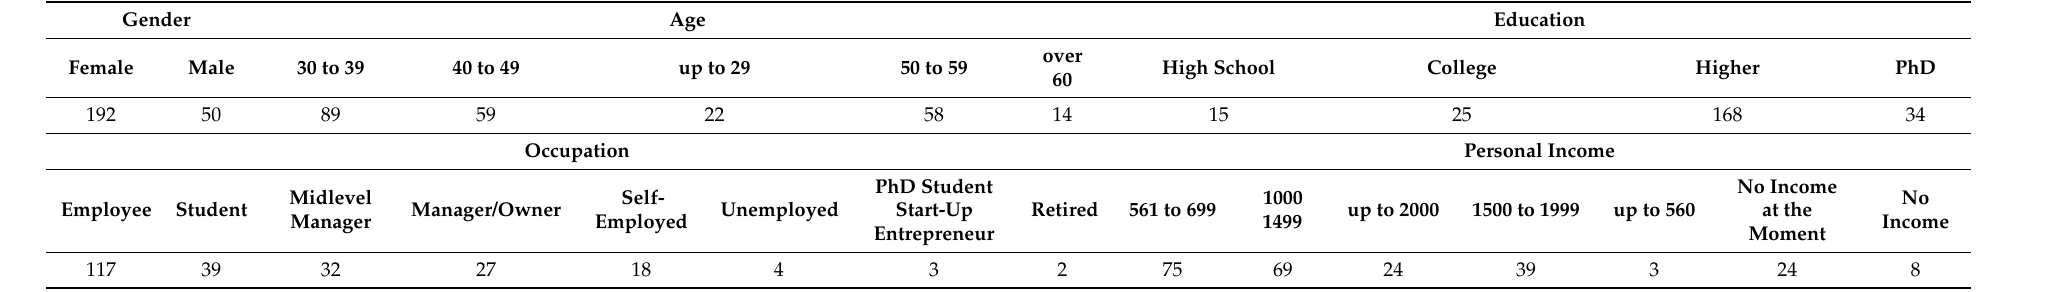
Table 1. Profile of